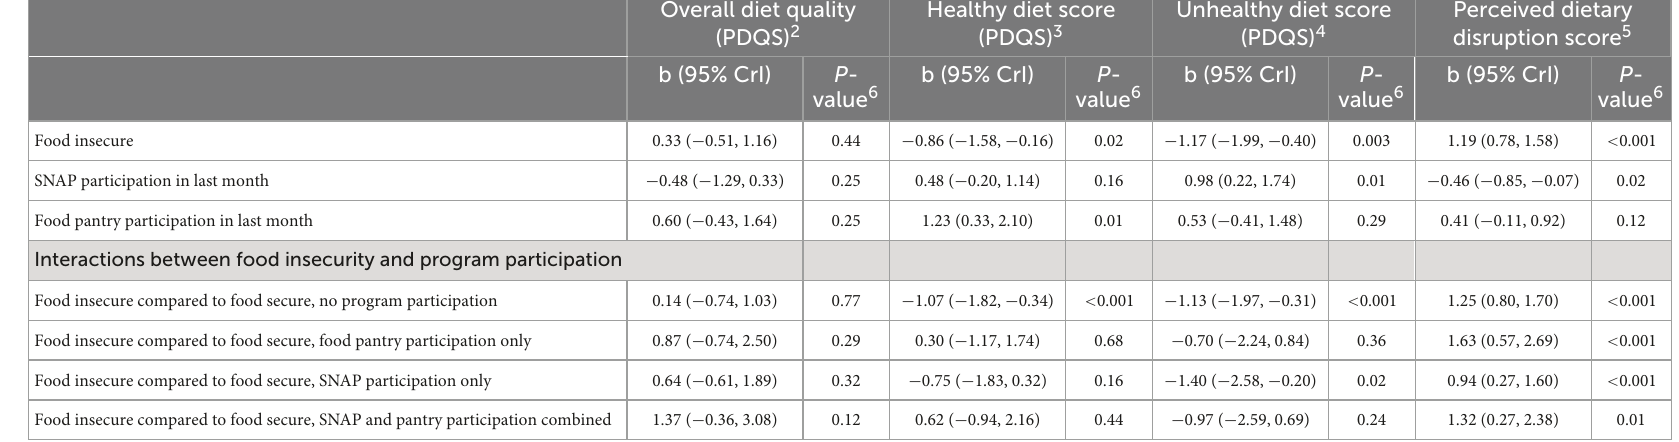
TABLE 2 Adjusted 1 mean diet disruption and PDQS score differences, by SNAP, food pantry, and food insecurity status, among low-income Massachusetts adults ( n = 1,256), Oct 2020 – Jan